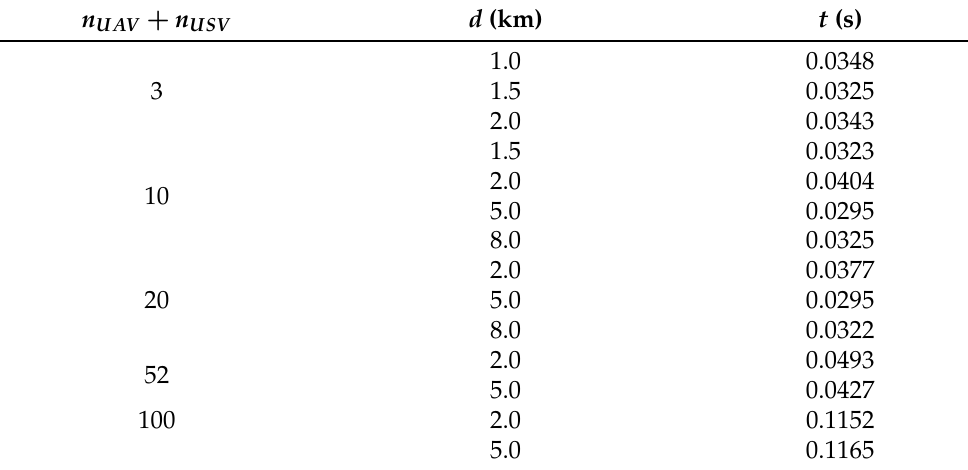
Table 9. Path division algorithm results: execution time with respect to distance between GW and WSN and number of